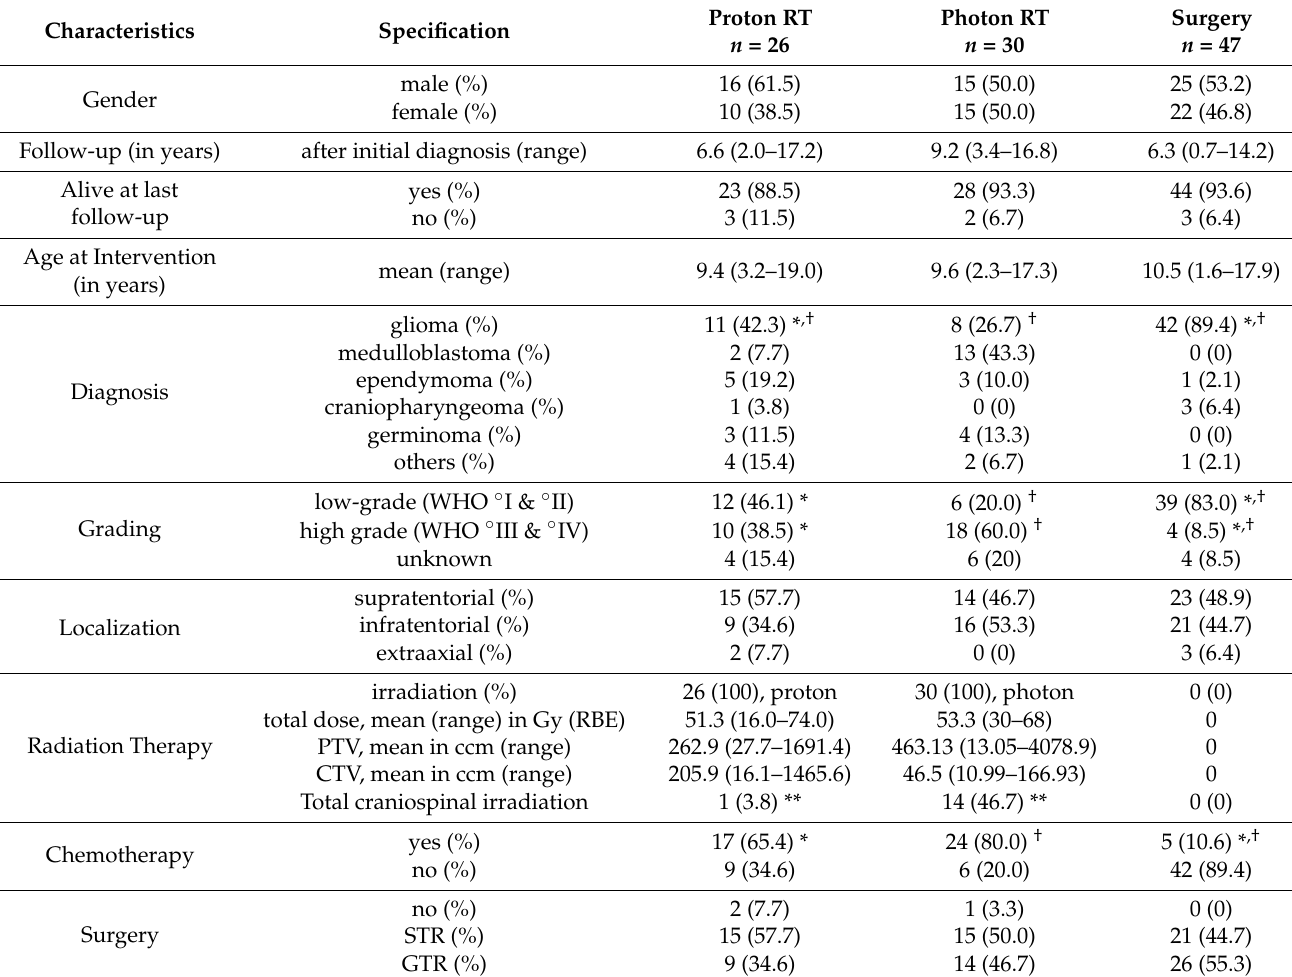
Table 1. Patient characteristics. Patient cohort with neurocognitive assessment in proton, photon, and surgery cohort.